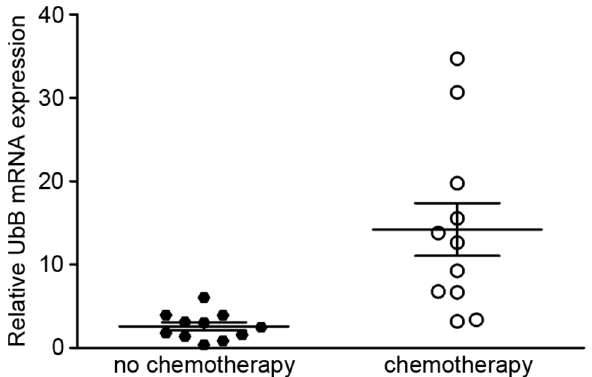
Figure 6. Relative expression of UbB in cervical cancer tissue samples. The expression of UbB in cervical cancer tissue samples with collected either initial presentation or after platinum-based chemotherapy were analysed. The UbB expression level was significantly higher in the chemotherapeutic samples than that in non-chemotherapeutic samples ( p =0.0059, two-way ANOVA test; n=22).